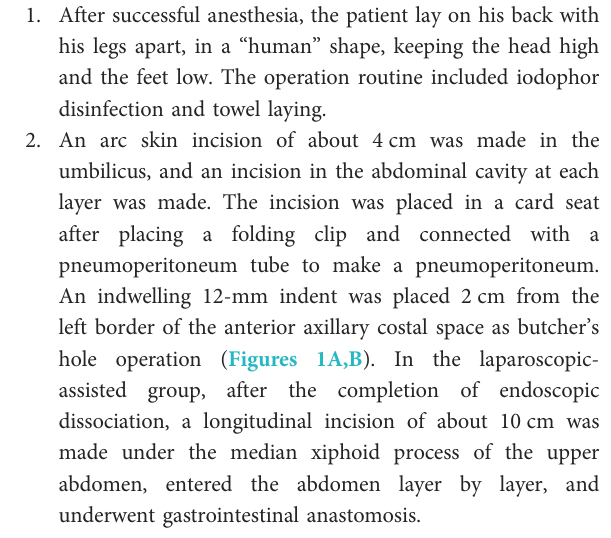
TABLE 1 Preoperative patient demographic